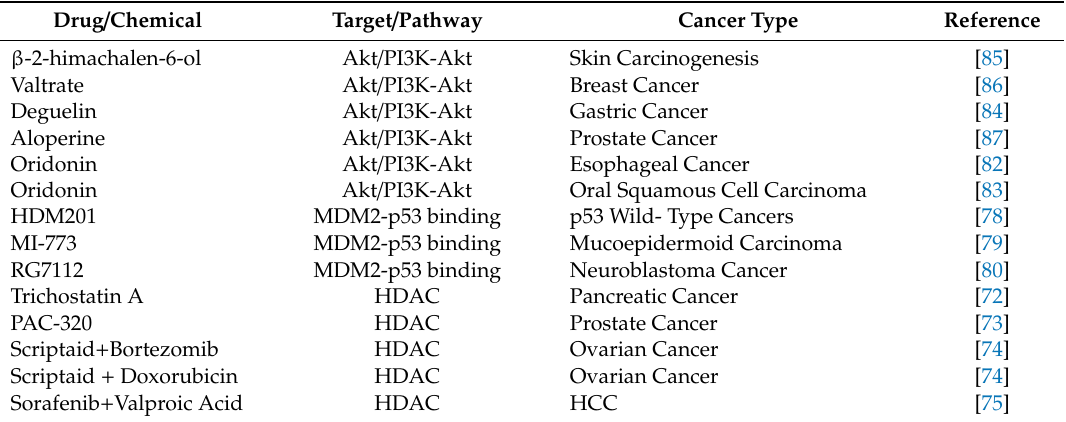
Table 2. Drugs / Chemicals that could be used to upregulate p21 expression; target pathways and studied cancer types are shown